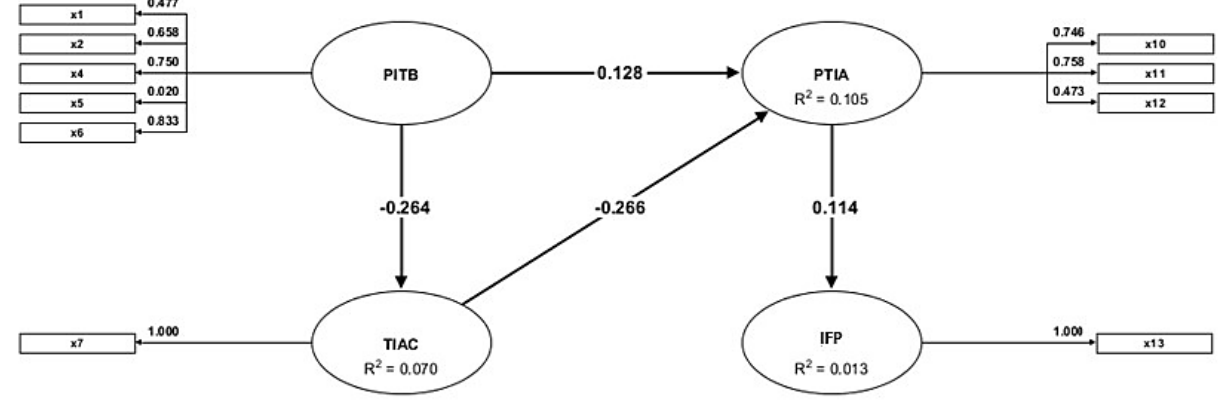
Figure 2. Empirical model: the overall structural equation model test